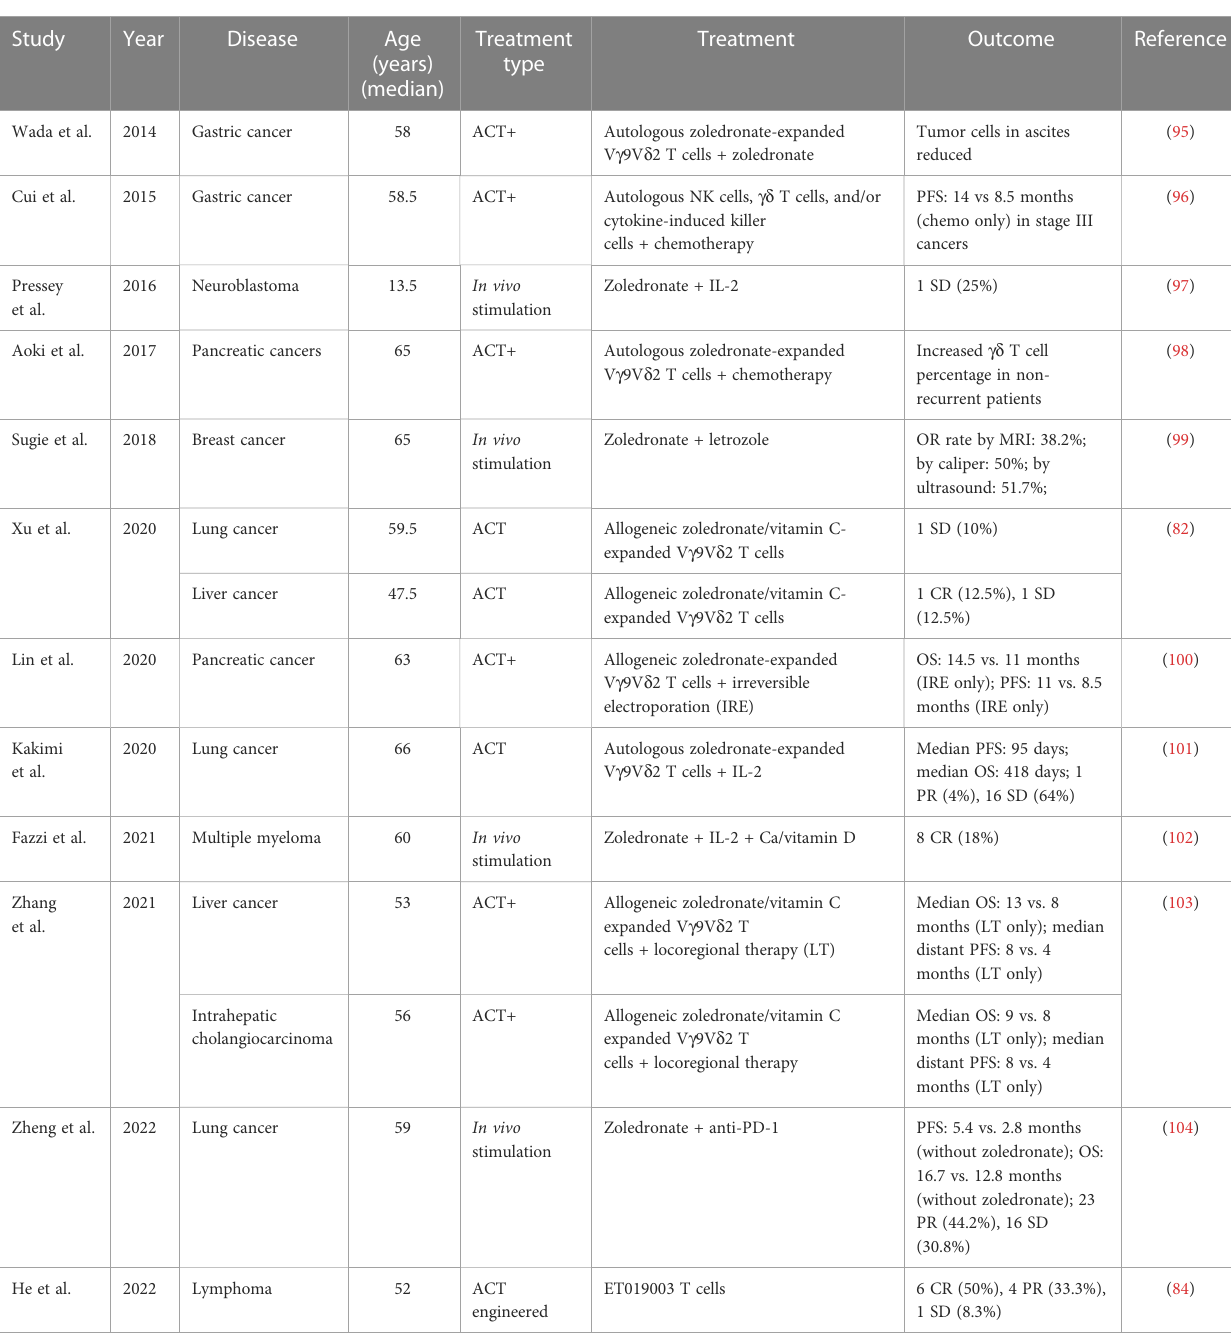
SD, stable disease; PR, partial response; CR, complete response; OS, overall survival; PFS, progression-free